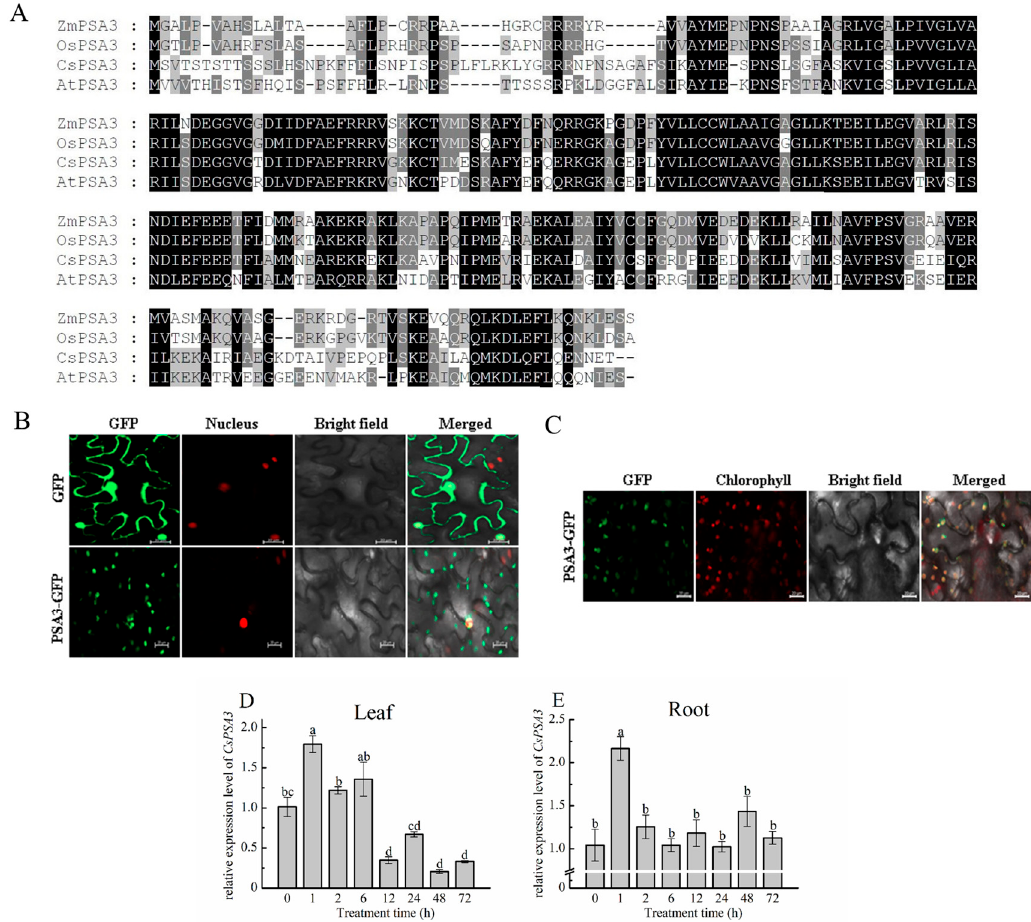
Figure 3. Amino acid sequence alignment ( A ) and subcellular localization ( B , C ) of CsPSA3, and time-course changes of CsPSA3 expression in leaf ( D ) and root ( E ) of salt-treated cucumber. Cucumber ( Cucumis Sativus , CsPSA3), Arabidopsis ( Arabidopsis thaliana , AtPSA3), rice ( Oryza sativa , OsPSA3), maize ( Zea mays , ZmPSA3). The different letters indicate expression levels that were significant different between different treatment time ( p < 0.05) according to Tukey’s test. Scale bars (20 μm) were added to the bottom right of each figure using ZEN 2 software